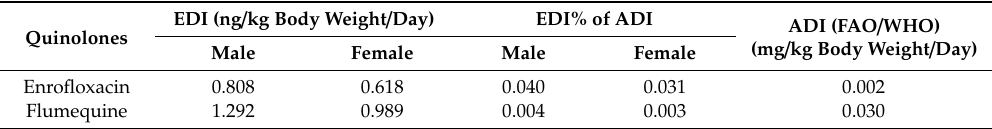
Table 3. Estimated daily intake of quinolone residue in bivalves by Taiwanese adults as percentage of acceptable daily intake quotient (ADI).